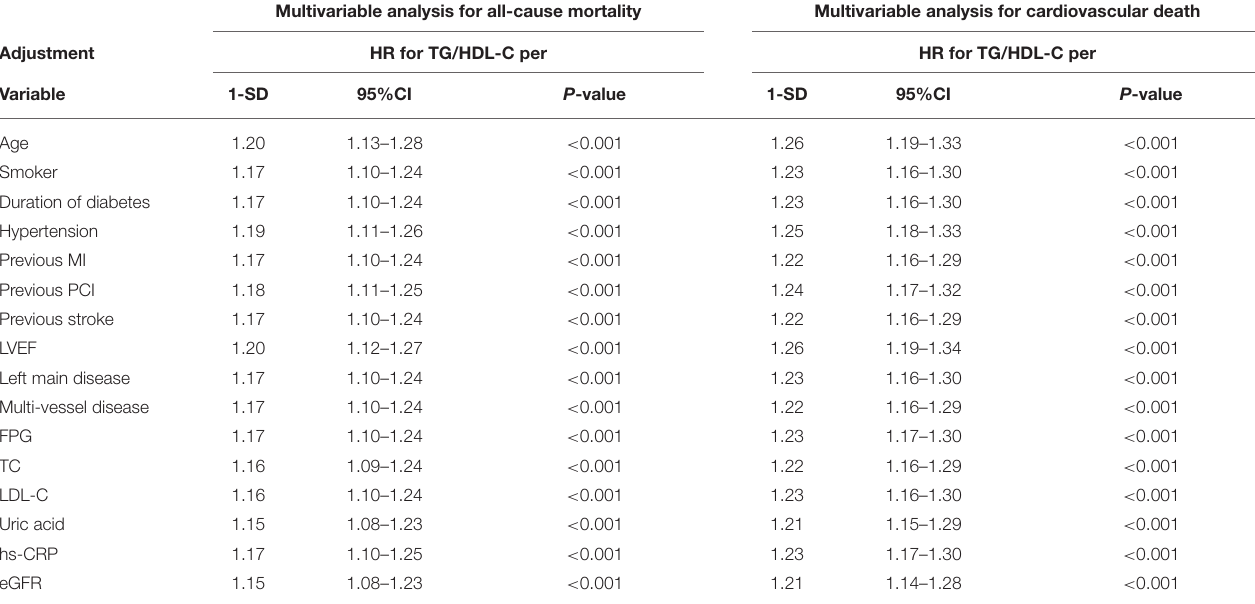
TABLE 3 | Sensitivity analysis of the association of the triglyceride to high density lipoprotein-C ratio per 1 standard deviation with mortality after separate adjustment for each of the other significant variables.